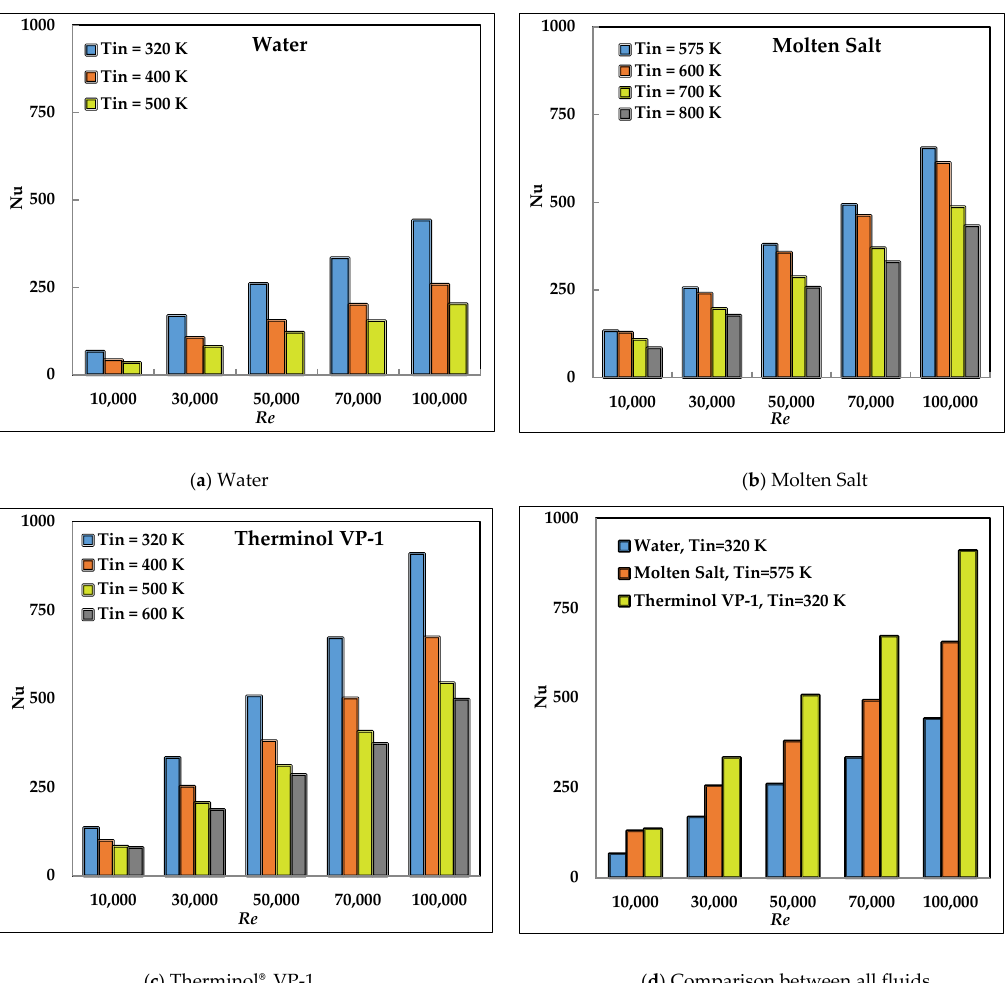
ff erent fluids used in the present Figure 6. Nusselt number profiles of different fluids used in the present work. Figure 6. Nusselt number profiles of di